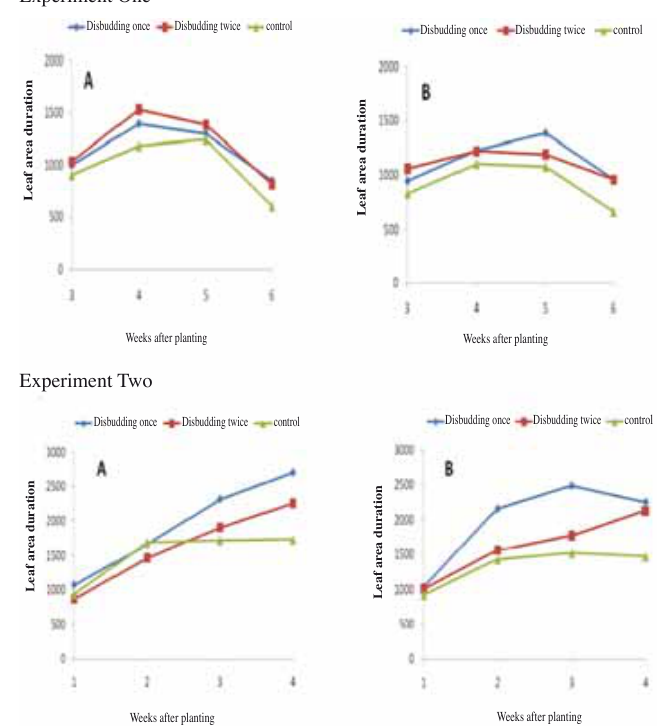
Fig. 8 - Leaf area duration as affected by disbudding and cultivar: ‘Car - mine’ (A) and ‘Chief Gold’